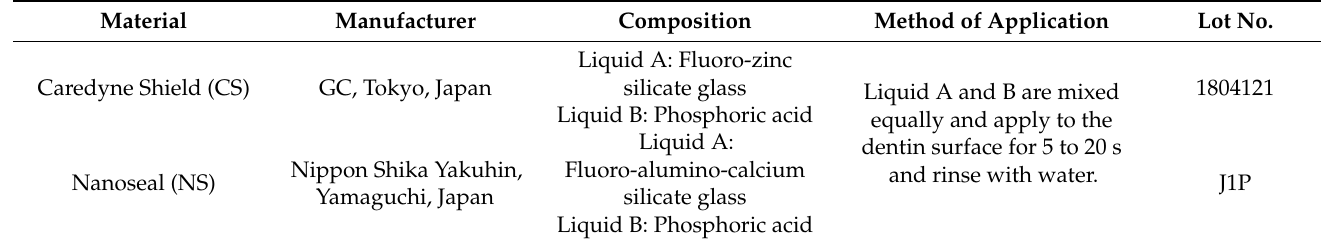
Table 1. Compositions and application methods of the